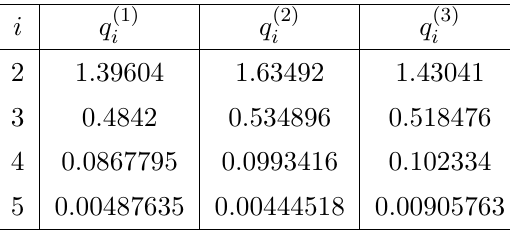
for eq. (B.8) and eq. j